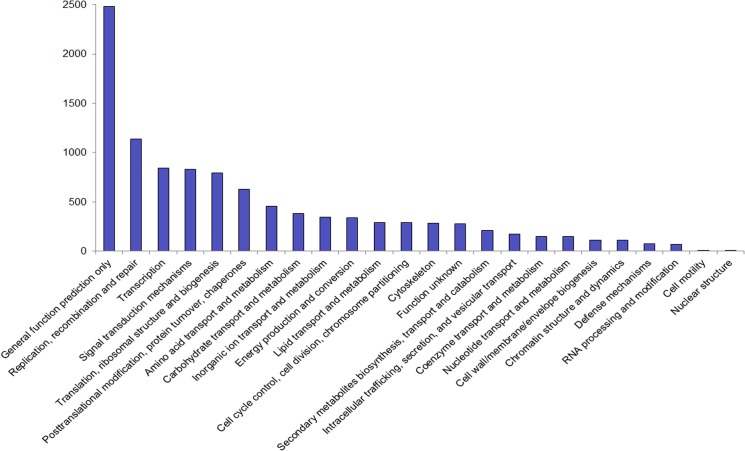
Clusters of orthologous groups (COG) classification.4,479 unigenes with Nr hits were grouped into 24 COG classifications.